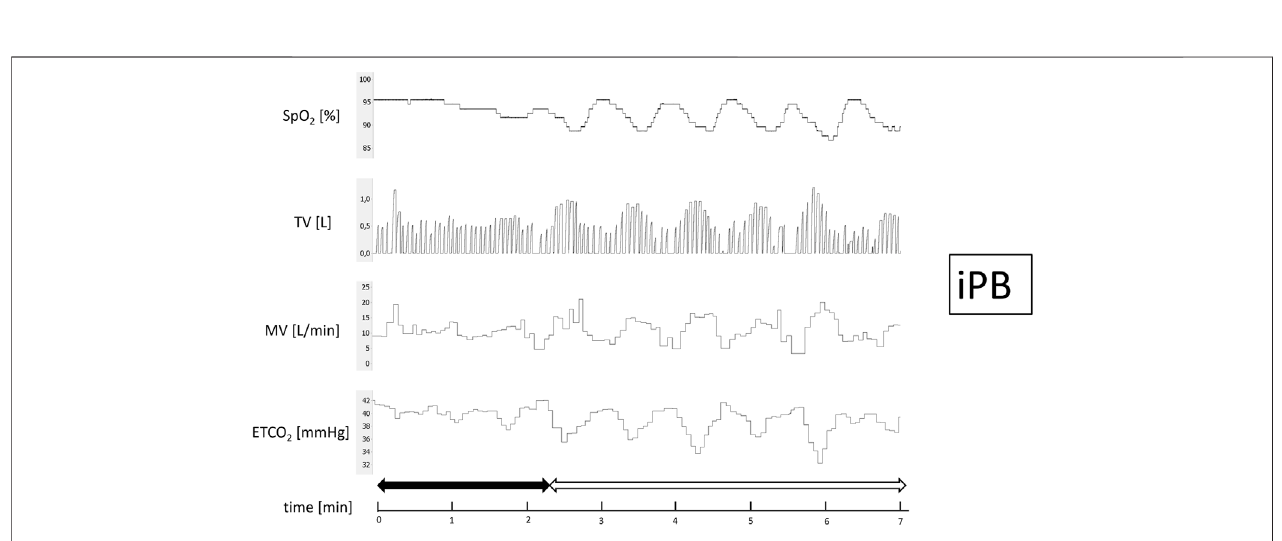
FIGURE 3 | Example of inducible periodic breathing (iPB). Continuous recording of oxygen saturation (SpO 2 ), tidal volume (TV), minute ventilation (MV), and end- tidal CO 2 (ETCO 2 ) during induction protocol. Nitrogen titration phase is depicted with solid arrow and fi nal nitrogen fl ow-rate phase with blank